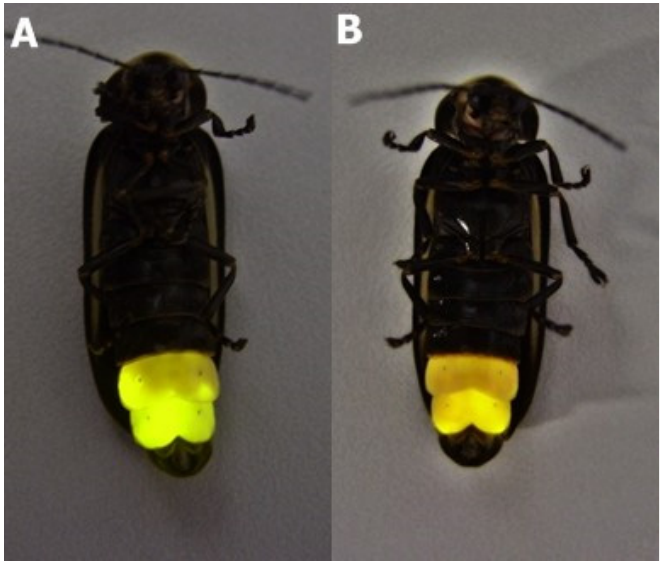
Figure 1. The Macrolampis sp2 firefly-induced bioluminescence display time-dependent color change after stimulation by anesthesia/adrenalin: ( A ) in the beginning just after adrenalin injection the color is yellow-green; ( B ) after 5 min, a subtle color change to yellow-orange is observable. Continuous glow stimulation may induce lantern acidification, causing the color change.